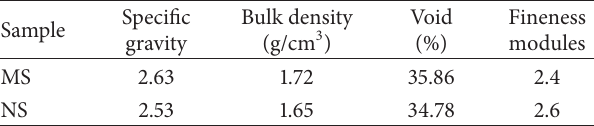
Figure 1: Particle size distribution of fine aggregate according to ASTM C-33. Table 1: Summary of the characteristics of the fine aggregate samples